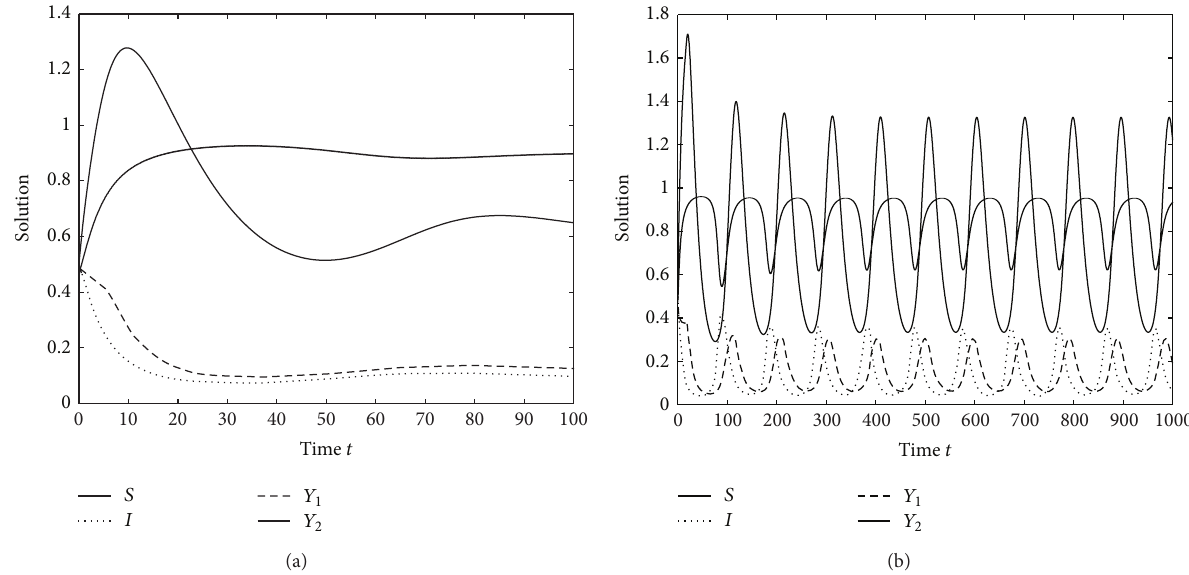
Figure 2: The temporal solution found by numerical integration of system (2) with (a) 𝜏 = 1 and (b) 𝜏 = 15 .